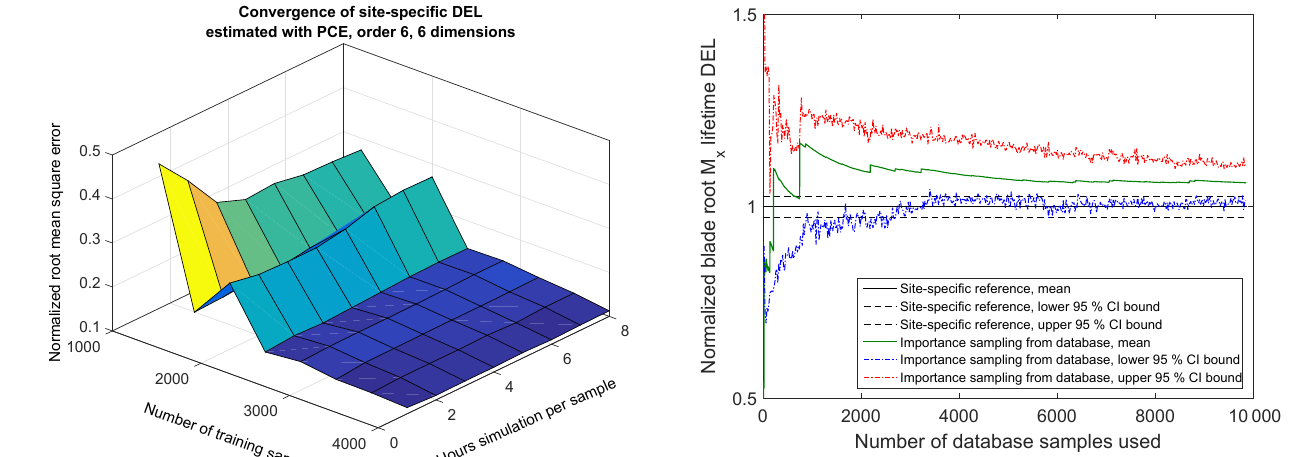
Figure 4. Convergence of a PCE of dimension 6 and order 6, as a function of number of collocation points and hours of simulation per collocation point. The z axis represents the NRMSE obtained from the difference between 500 site-specific quasi-MC samples of blade root flapwise DEL for reference site 0, and the corresponding predictions from PCE.